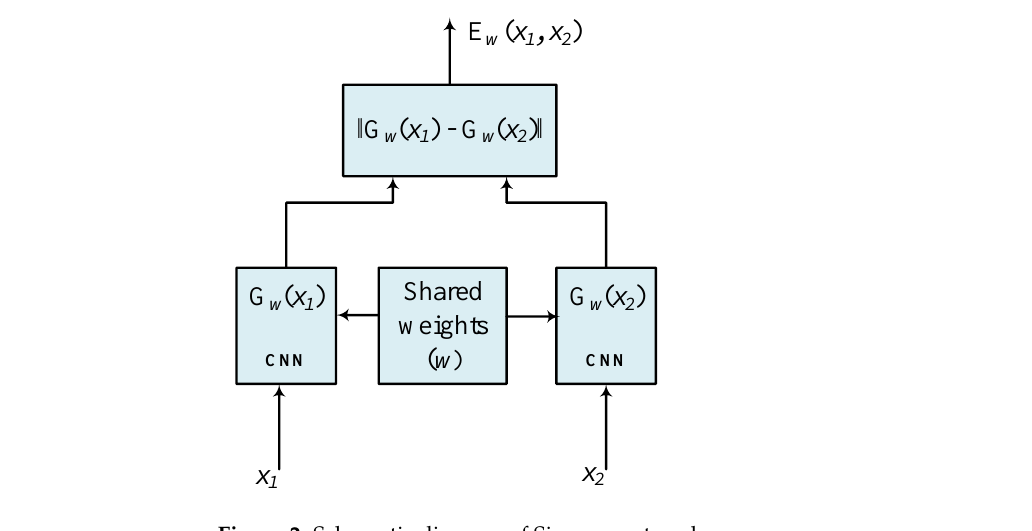
Figure 2. Schematic diagram of Siamese network.